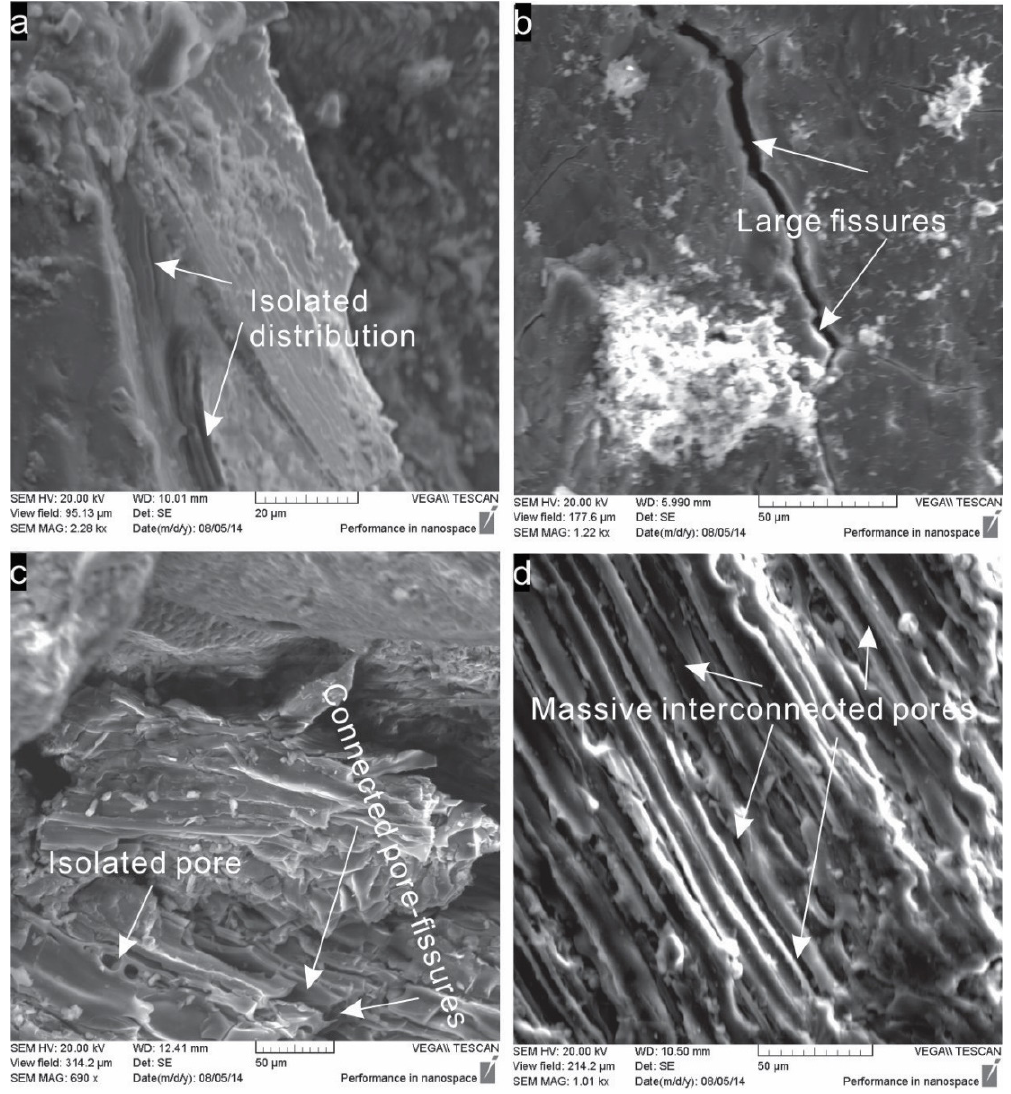
Figure 10. Microscopic characteristic of pore and fissure in the selected samples from the southern Junggar Coalfield. ( a ) Sample CL1 in coal facies (1); ( b ) Sample CL3 in coal facies (2); ( c ) Sample CL2 in coal facies (3); ( d ) Sample QY1 in coal facies (4).